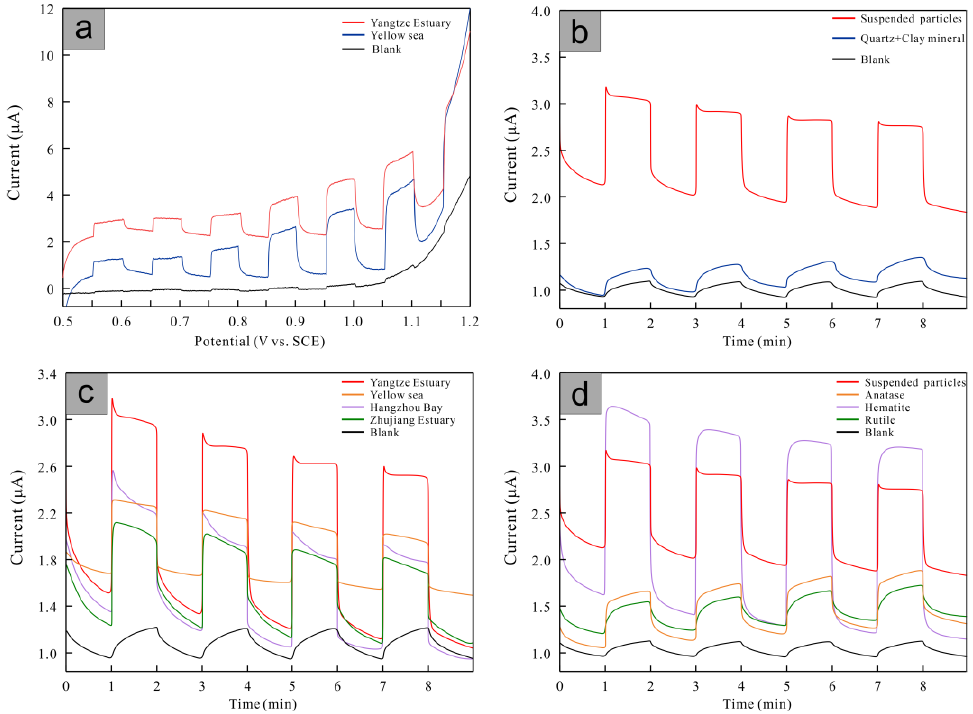
Figure 6. ( a ) Linear sweep voltammetry curve of suspended particulate matters. ( b – d ) I-t curve of suspended particulate matters.